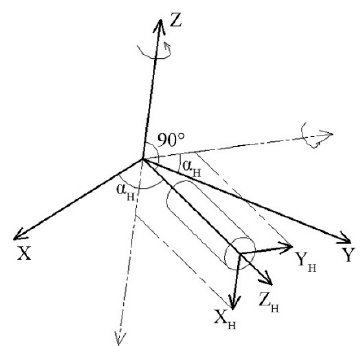
Figure 2. Transformation of the stress state between the in-situ stress and horizontal borehole coordinate